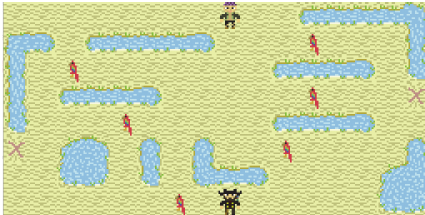
Figure2:Animageofthevideogamewedesignedasanexperimen- tal environment. The player controls the humanoid on top, while the AIcontrolsthehumanoidthatstartsatthebottom.Goalsaremarked by the red Xs on the